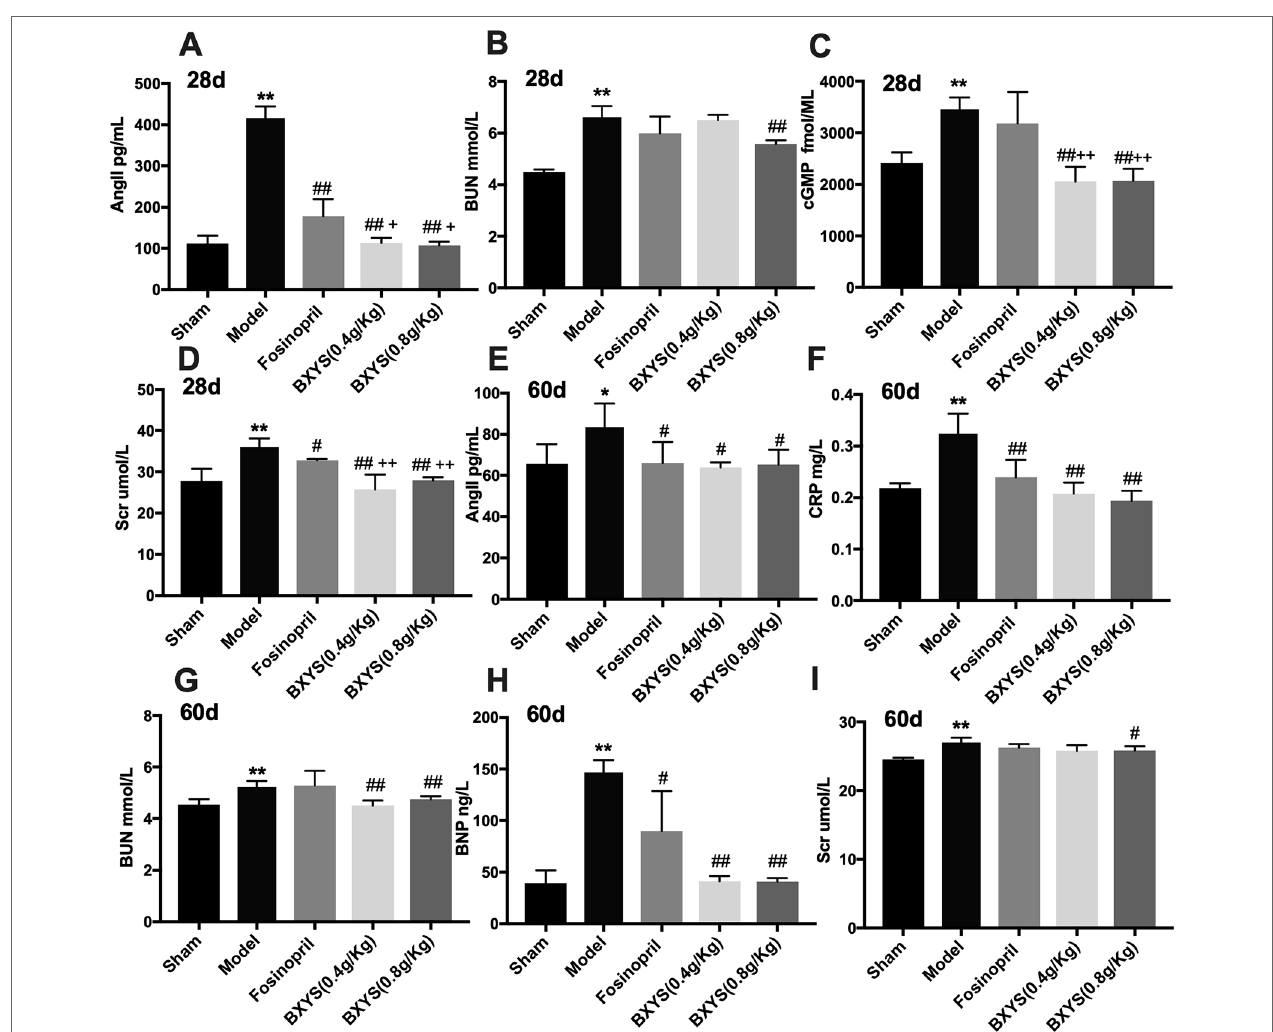
FIGURE 3 | Measurement of neuroendocrine factors after 28 days and 60 days of drug administration. Sham, sham group; Model, model group; Fosinopril, fosinopril group; BXYS (0.4g/kg), Buxin Yishen 0.4 g/kg treated group; BXYS (0.8 g/kg), Buxin Yishen 0.8 g/kg treated group. *P < 0.05, **P < 0.01 vs. sham group. # P < 0.05, ## P < 0.01 vs. model group. + P < 0.05, ++ P < 0.01 vs. fosinopril group. (A) Serum concentration of angiotensin II (Ang II) after 28 days. (B) Serum concentration of blood urea nitrogen (BUN) after 28 days. (C) Serum concentration of cyclic guanosine monophosphate (cGMP) after 28 days. (D) Serum creatinine (Scr) after 28 days. (E) Serum concentration of Ang II after 60 days. (F) Serum concentration of C reaction protein (CRP) after 60 days. (G) Serum concentration of BUN after 60 days. (H) Serum concentration of brain natriuretic peptide (BNP) after 60 days. (I) Serum concentration of Scr after 60